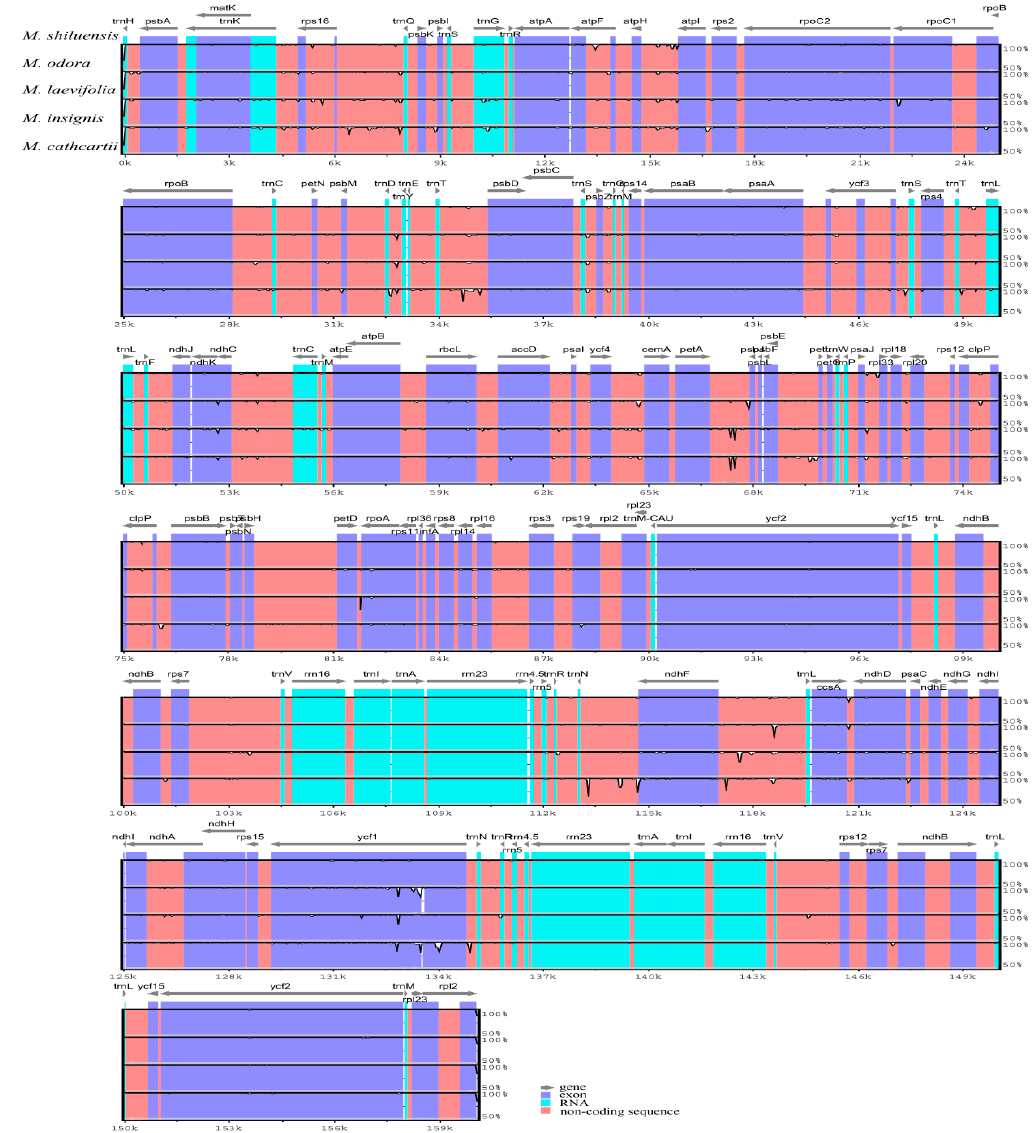
Figure 4. Sequence alignment of five whole chloroplast genomes in Magnoliaceae ( Michelia shiluensis , Michelia odora , Magnolia laevifolia , Magnolia insignis , and Magnolia cathcartii ) using M. shiluensis as a reference in mVISTA .